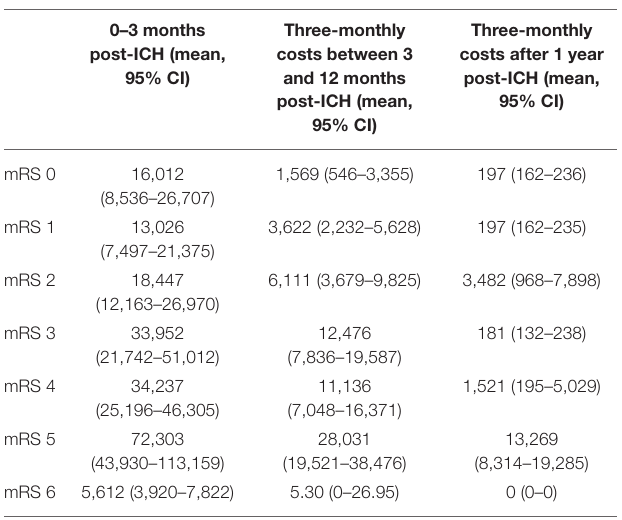
TABLE 4 | Costs (in